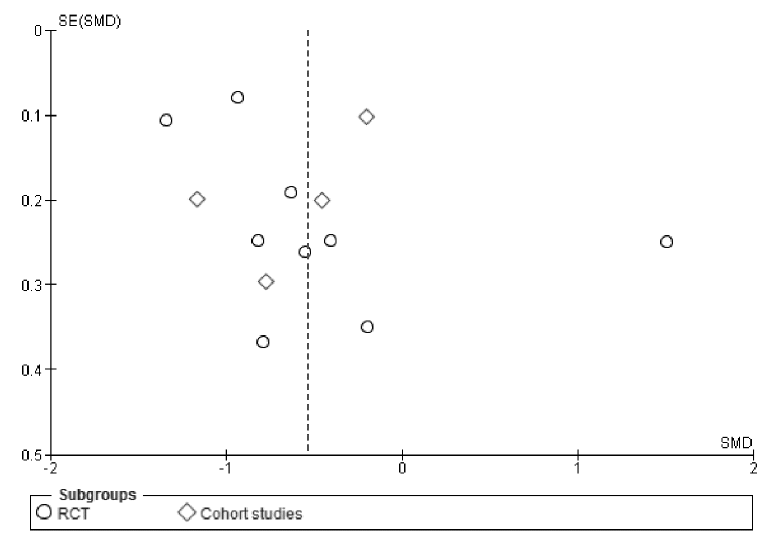
Figure 3. Funnel plot of standard error by standard differences in means of body weight.